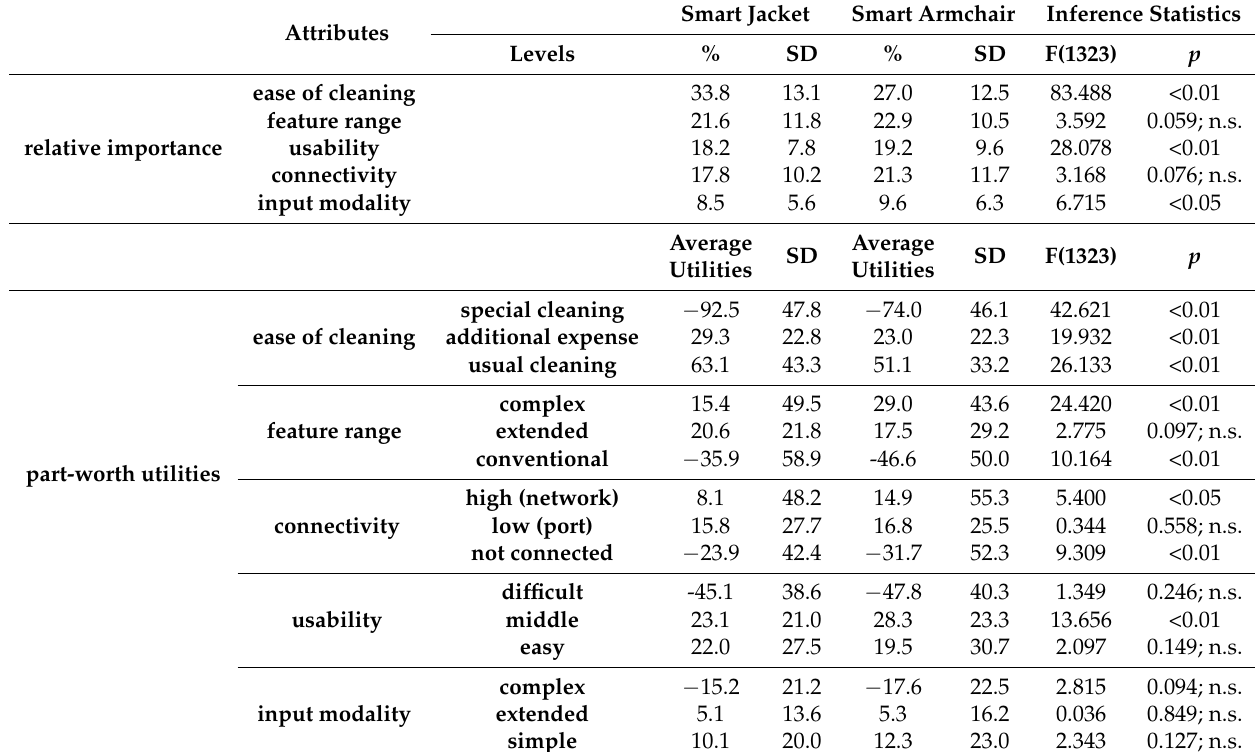
Table A2. Descriptive and inference statistics referring to the conjoint decisions comparing smart jacket and smart armchair for the whole